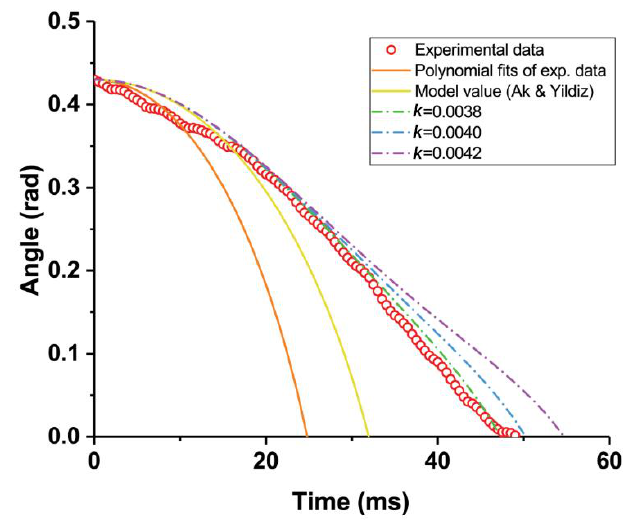
Figure 8. Experimental and theoretical data fitting graphs. The actual angular changes tracked at 0.5 ms intervals and fitting line (dash line). The theoretical model and previous model are also depicted as graphs. For correcting error, restoring energy with constant k also considered (dash-dot line).